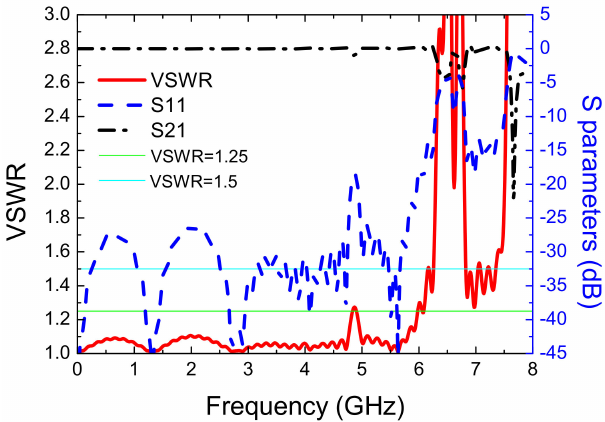
Figure 12. S-parameters and VSWR simulation results of the IC-Stripline cell based on image theory. S33 is similar to S11, and S43 is similar to S21.